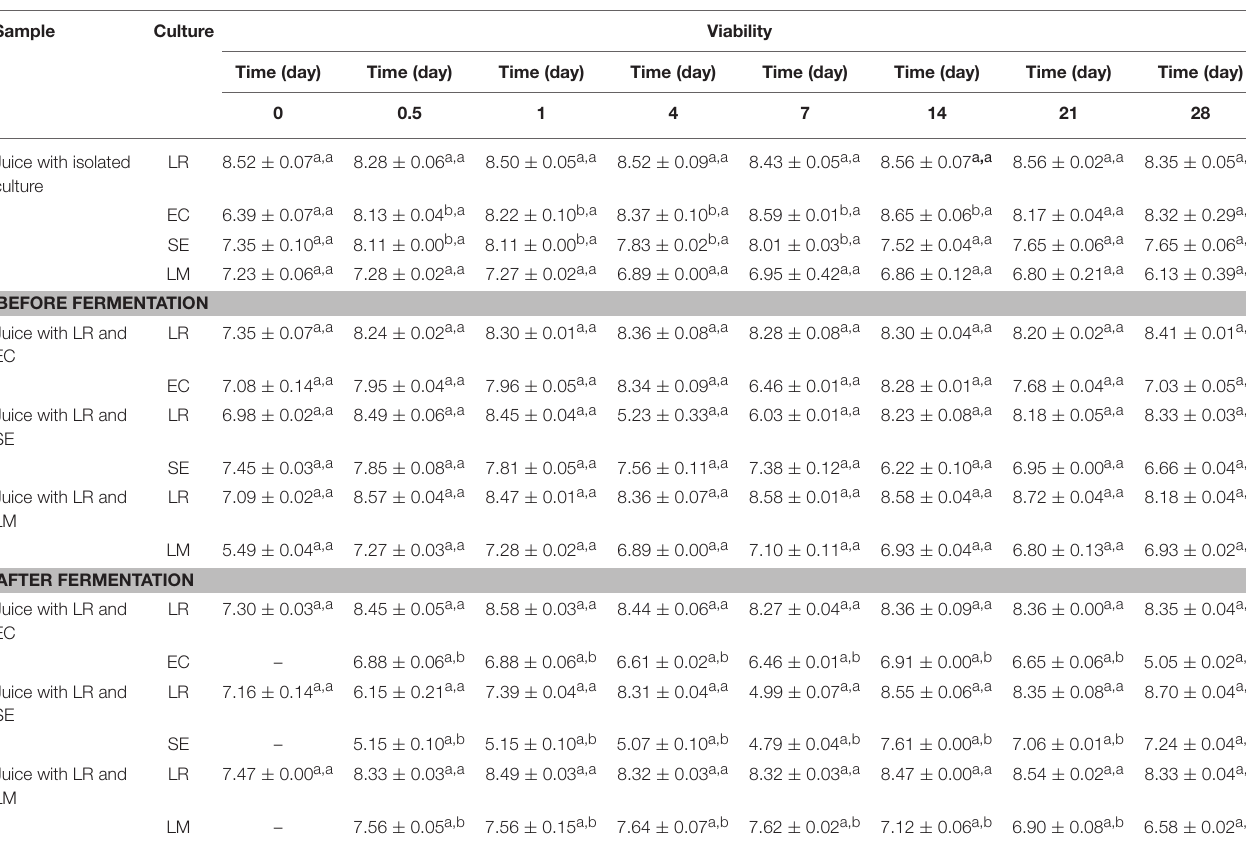
TABLE 2 | Cell viability of pathogens added after and before fermentation in intentionally contaminated grape beverages fermented by Lactobacillus rhamnosus and stored for 28 at ± 4 ◦ C(first latter indicates cell count difference a long time using Anova; second latter indicates cell count difference comparing to control using t -test.